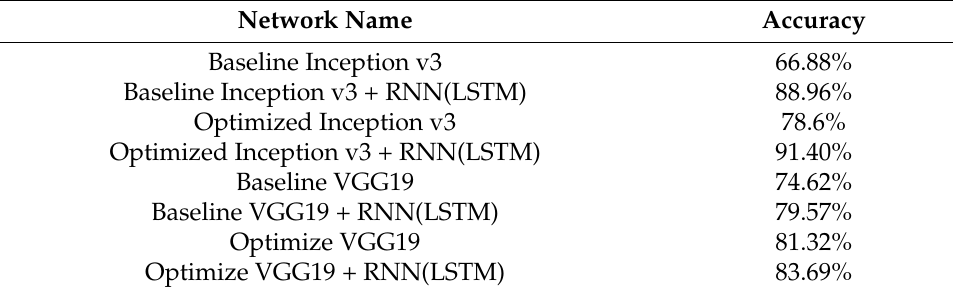
Table 1. Accuracy comparison of the detection of